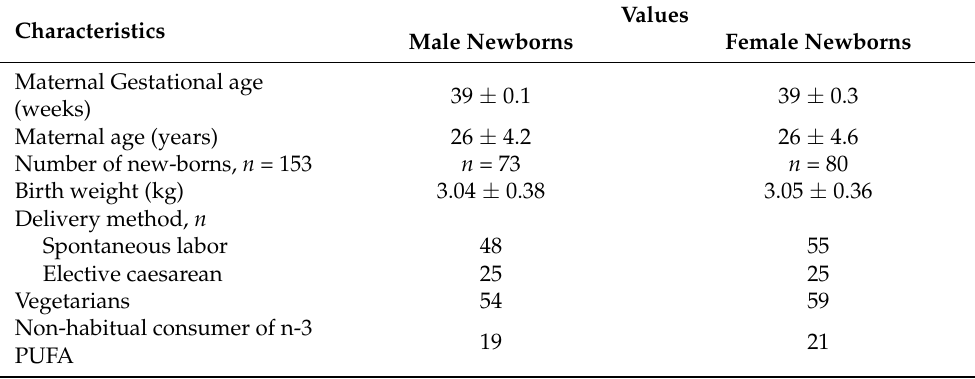
Table 1. Baseline characteristics of pregnant south Indian women and newborns in the